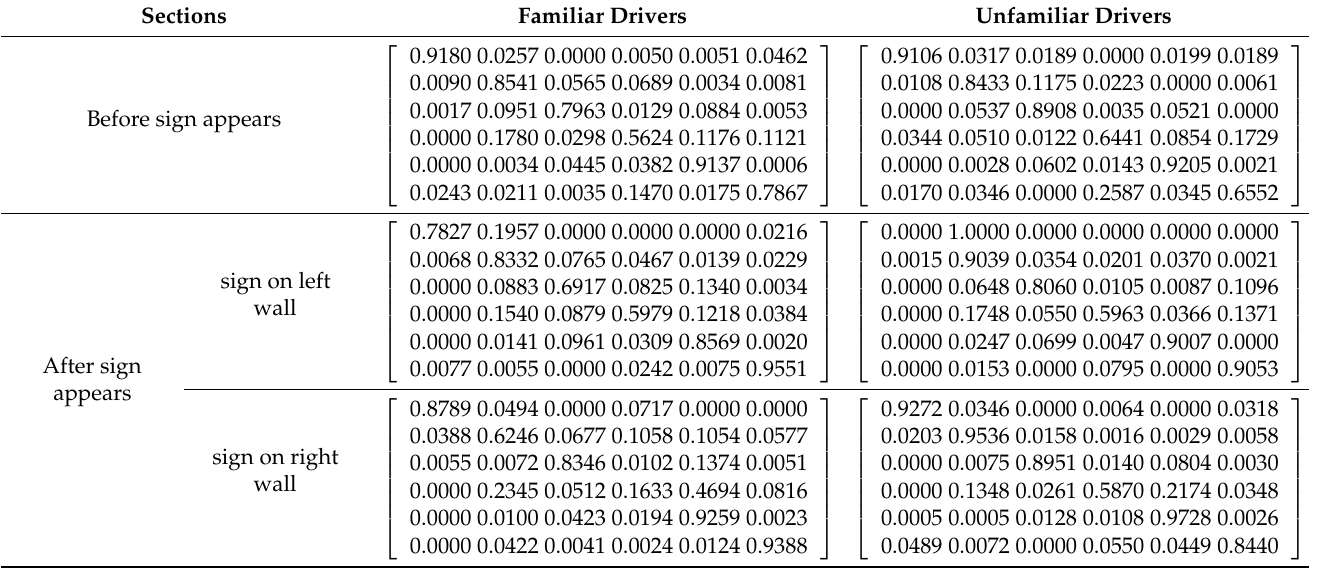
Table 1. One-step gaze transition probability matrix in